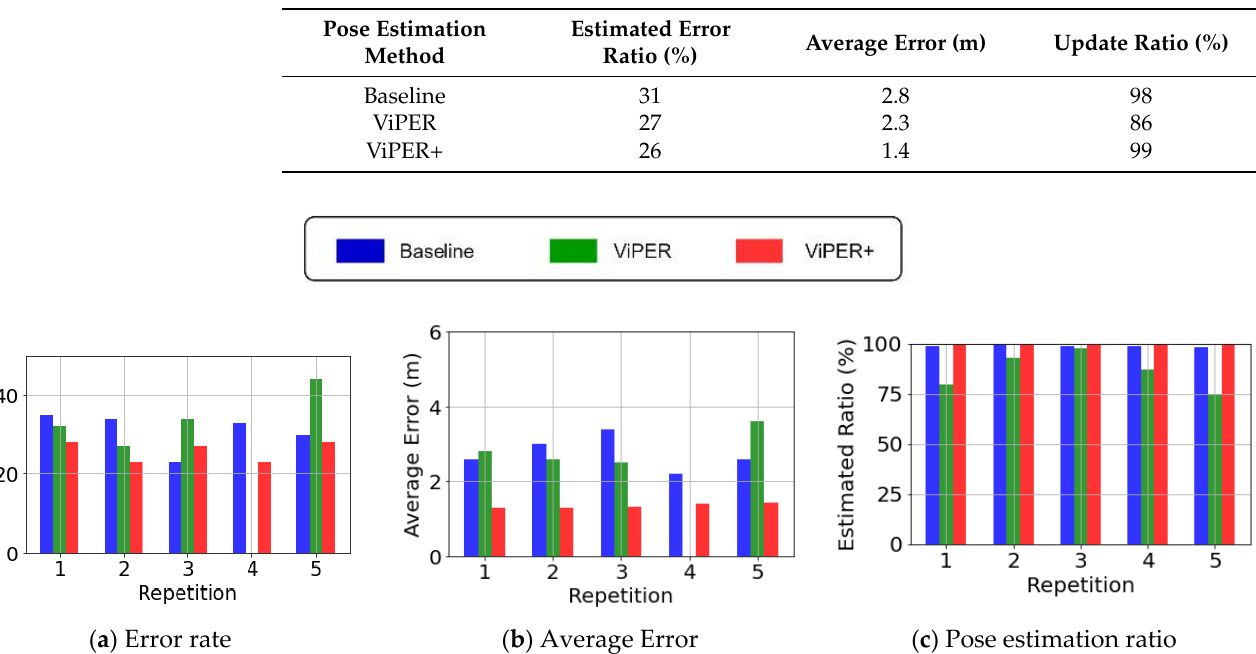
Table 4. Pose estimation result for NLOS scenario. ViPER+ provided the same update rate as the baseline method while reducing the error rate and average error compared to the baseline.